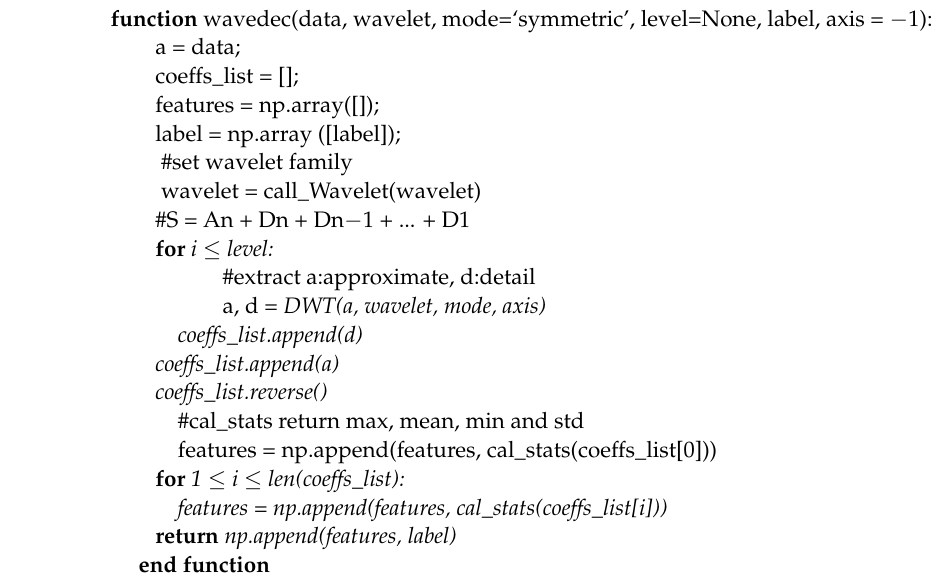
Algorithm 1. Feature Extraction Algorithm.